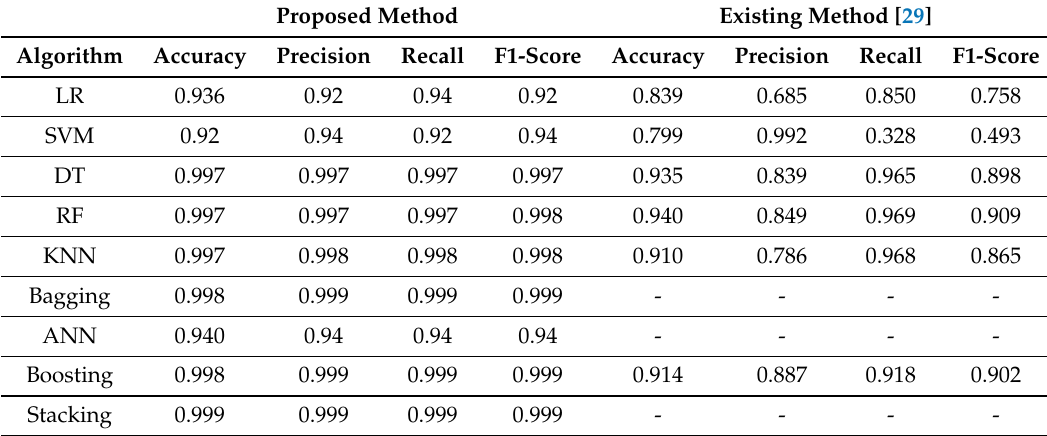
Table 10. Comparison of binary classification performance on CICIDS2017.